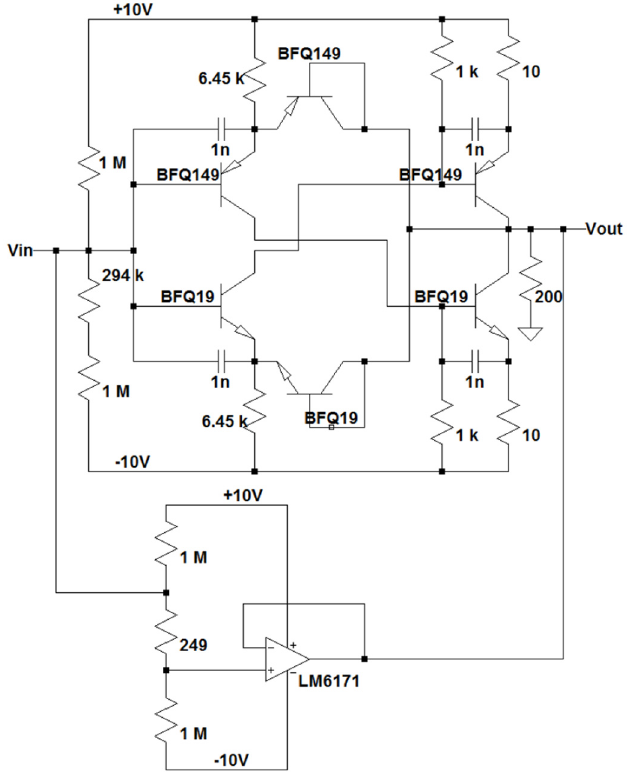
Fig. 1. Schematic of the voltage buffer where Vin is the input female N-connector and Vout is the output male N-connector. The ground on the power supply is coupled to the chassis and outer conductor of the N-connectors. The main buffer core is the push-pull coupled Sziklai pairs (NPN: BFQ19, PNP: BFQ149) with diode-coupled (base-collector is shorted) feedback. The module based on the LM6171 operational ampli fi er serves as a voltage follower which senses and corrects for the errors in the output waveform produced by the previously mentioned buffer core. The non-inverting input has been shifted downwards in voltage to compensate for the internal offset in the